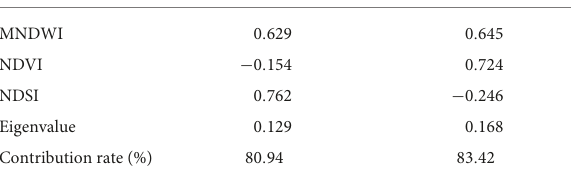
TABLE 6 The principal component analysis of three ecological